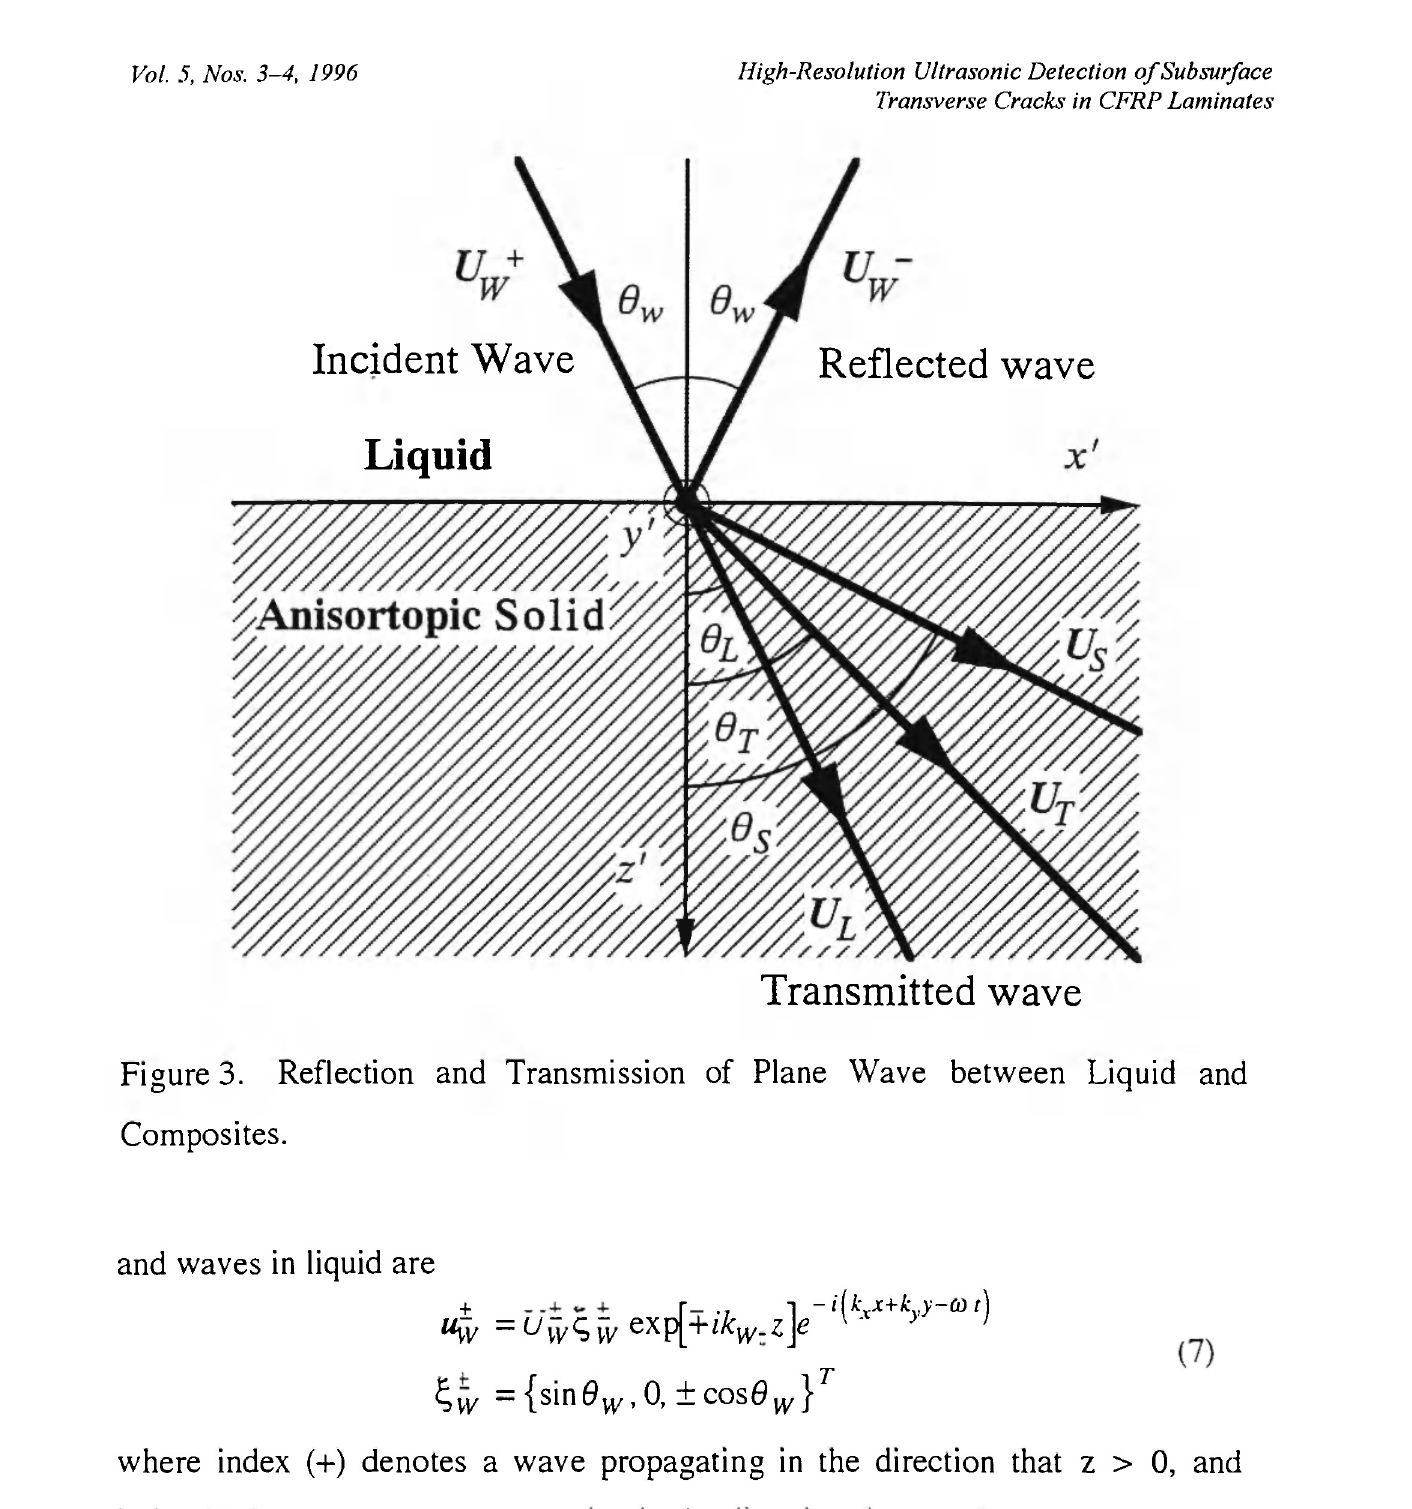
Figure 3. Reflection and Transmission of Plane Wave between Liquid and